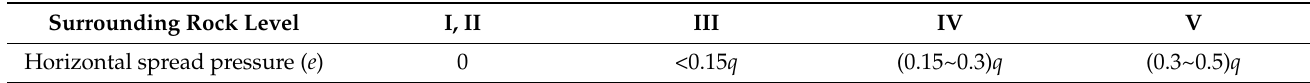
Table 3. Water level distribution pressure of deep buried tunnels.